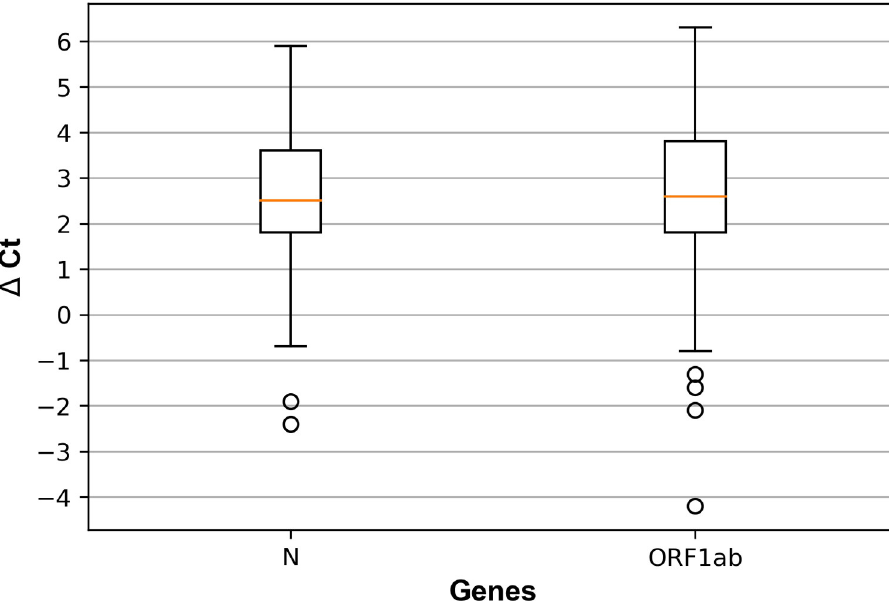
Fig 2. Ct value shift due to sample pooling. Box plot showing the difference between the Ct values ( Δ Ct) of five- samples pools (composed of 1 positive and 4 negative samples) and the respective individual positive samples for N and ORF1ab target